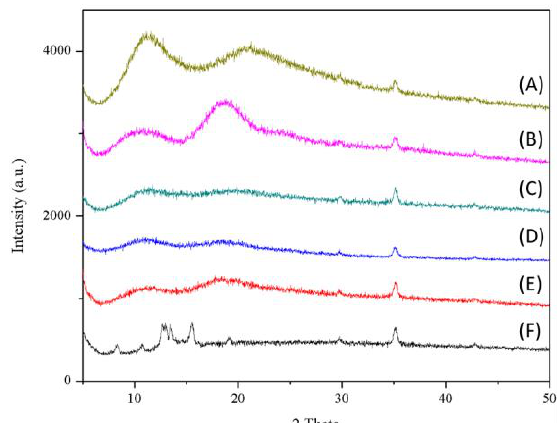
Figure 4. X-ray diffractometer (XRD) spectra of raw OA, OAnf with different ratios, and excipients. ( A ) PVPK90, ( B ) HPBCD, the different ratio of OAnf (OA:PVP:HPBCD, w / w / w ) ( C ) 1:8:5, ( D ) 1:8:10, ( E ) 1:8:20, and ( F ) oleanolic acid.